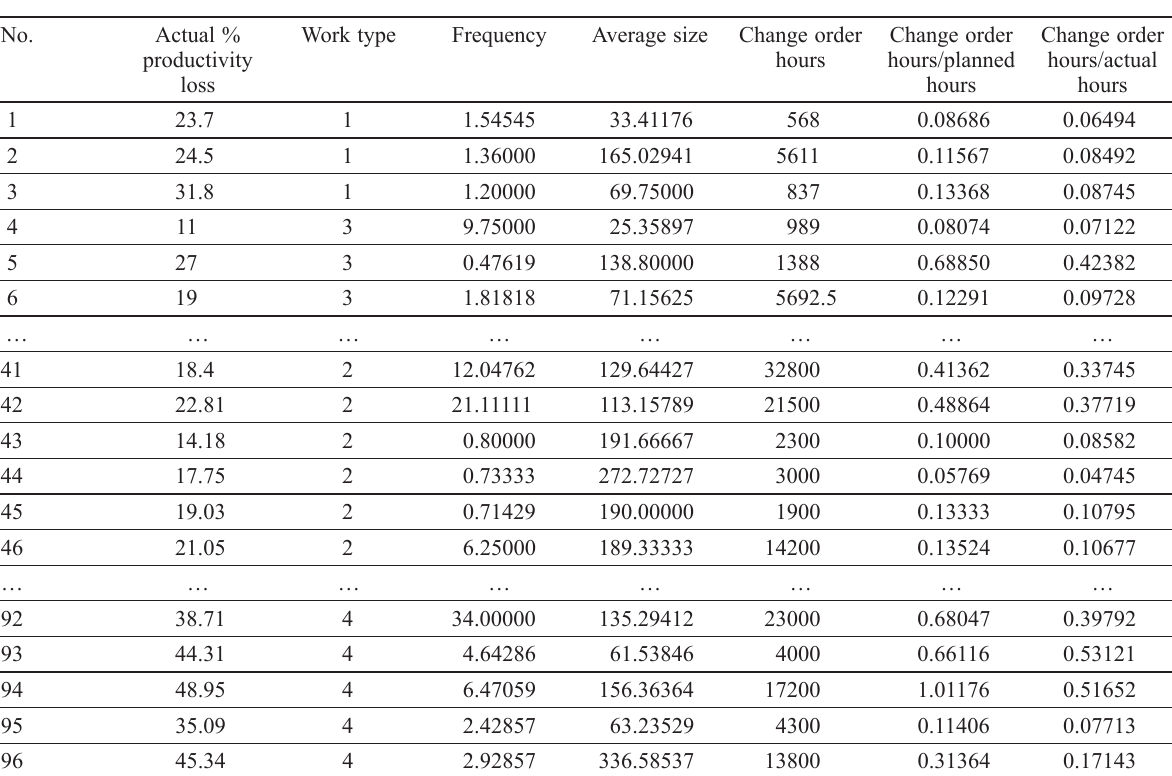
Table 4. Input and output data for Analysis 1